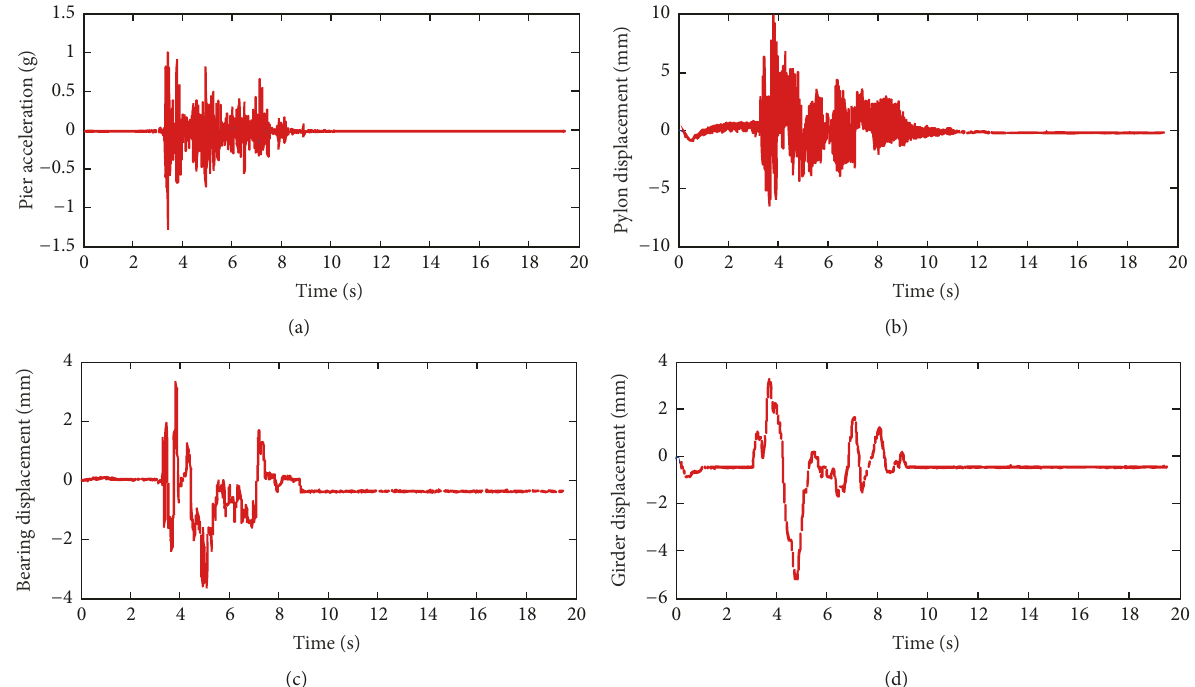
Figure 8: Time-history responses of four components: (a) pier acceleration; (b) pylon displacement; (c) bearing displacement; and (d) girder displacement for EI-Centro wave (0.8g).